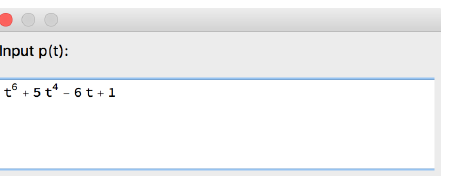
Figure 35. Output given by the [ARoots] algorithm.